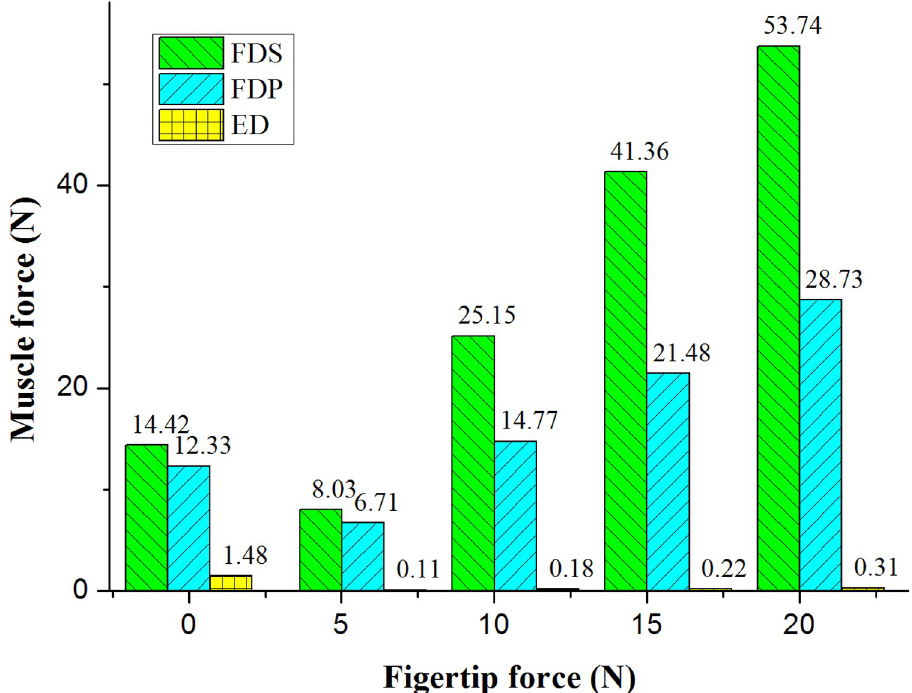
Fig 9. Variation of muscle forces of the three muscles with fingertip forces during flexion movements.